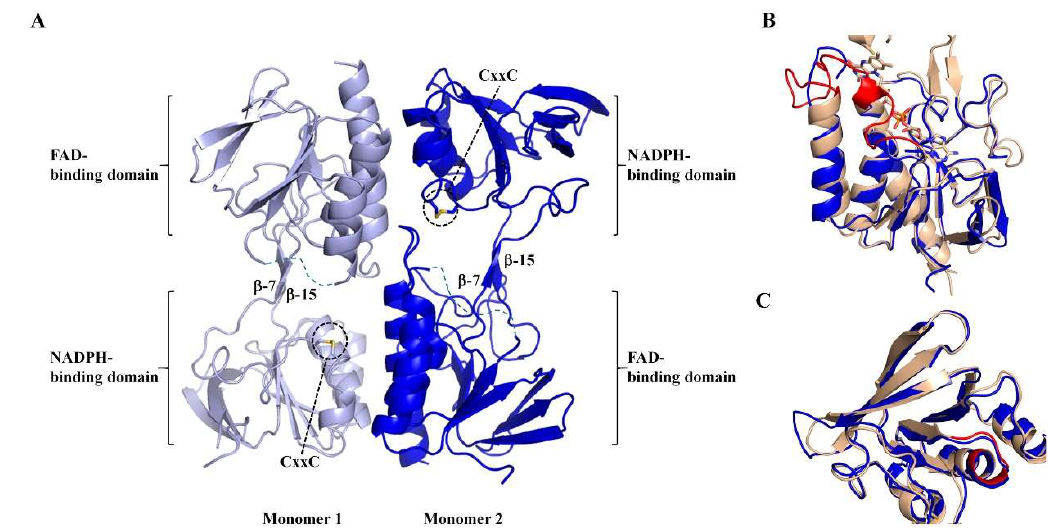
Figure 3. The crystal structure of MmNTR shown in a cartoon representation. ( A ) Monomers of MmNTR homodimers fold into two domains: The FAD-binding domain and the NADPH-binding domain. The Cys of the CxxC motif at the NADPH-binding domain are shown in sticks. The two domains are connected by two beta-strands ( β -7 and β -15) that facilitate the conformational flexibility of the molecule. The redox-active disulfide faces inwards, where it would be accessible to reduction by the flavin, and the NADPH-binding site exposed to the solvent. The missing parts of the final model are indicated by dotted lines. ( B , C ) Fold comparison of FAD- and NADPH-binding domains, respectively, of MmNTR (in blue) and SaNTR (PDB code 4GCM, in brown). No electron density of FAD was found at the expected cofactor-binding pocket in MmNTR, despite the well-defined and conserved FAD-binding cavity in the folded module. The FAD from SaNTR is drawn as sticks. The FAD-loop and NADPH-binding motif are colored in red.